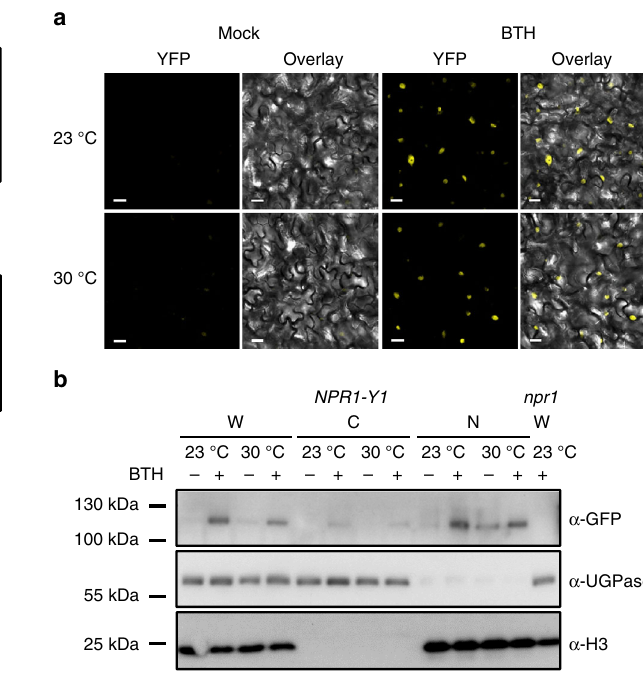
Fig. 4 Induction of NPR1 nuclear localization is retained at